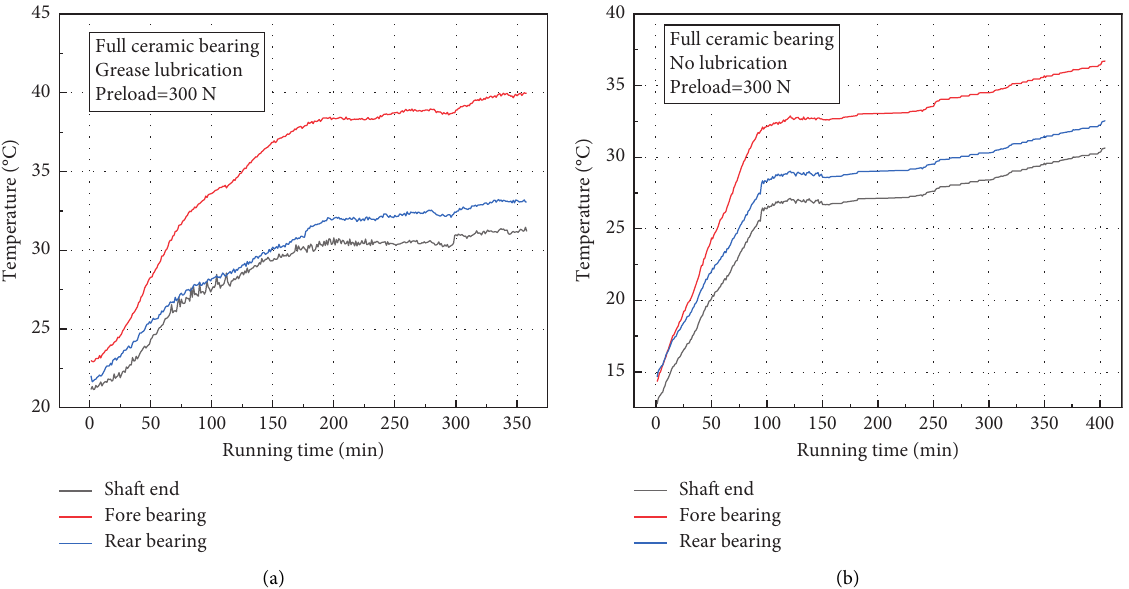
Figure 15: Temperature rise of Si 3 N 4 full-ceramic bearings under different lubrication conditions. (a) Condition of grease lubrication. (b) Condition of no